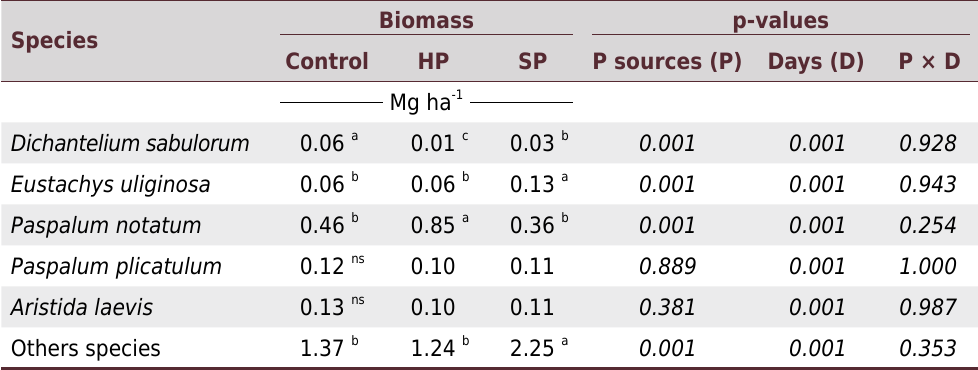
Table 2. Biomass of native species in a natural grassland from Southern Brazil affected by the application of different P sources Biomass Species